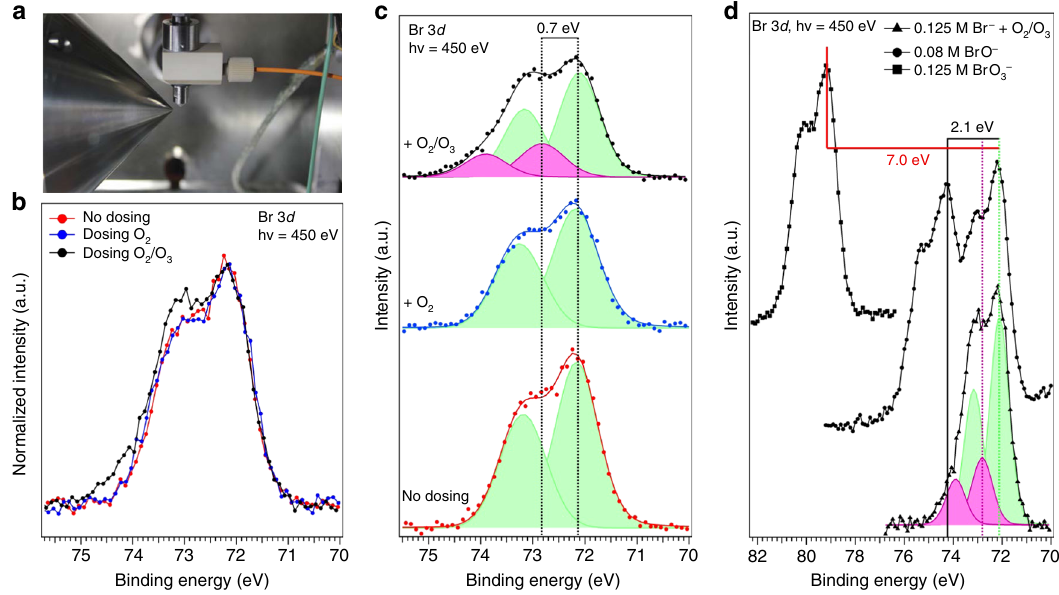
Fig. 3 Photoemission spectra of the Br 3 d peak acquired in situ. a Picture of the liquid microjet assembly, equipped with the gas dosing system, during operation; b Superimposition of the Br 3 d photoemission spectra, normalized to the maximum, acquired before dosing ( red ), while dosing oxygen ( blue ), and while dosing a mixture of 1% ozone in oxygen; c deconvolution of the raw spectra in plot b , performed using Gaussian peaks after subtraction of a Shirley background; d comparison of the Br 3d photoemission spectra acquired while dosing a mixture of 1% ozone in oxygen with two reference spectra of hypobromite and bromate